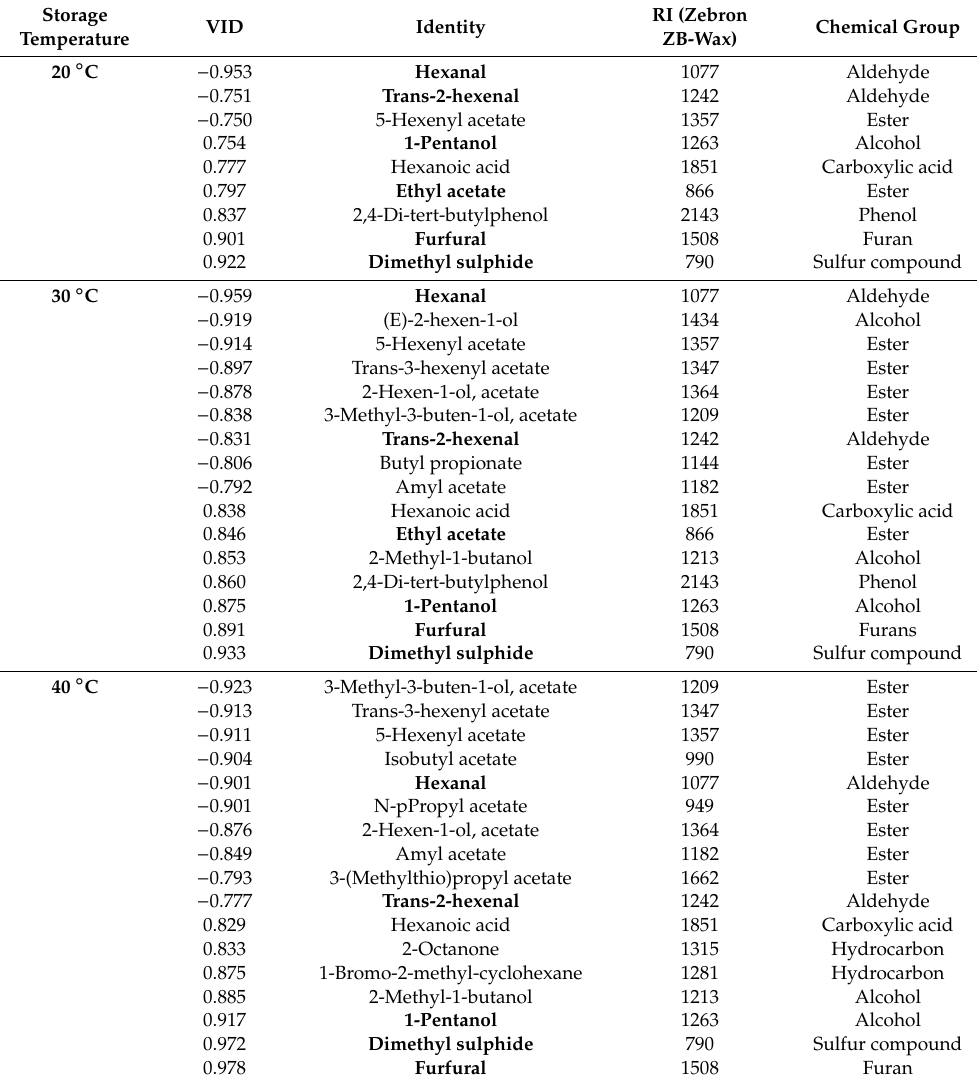
Table 1. Headspace compounds significantly changing during storage at each 20 ◦ C, 30 ◦ C and 40 ◦ C storage temperatures. Volatiles selected as potential shelf life markers / indices are put in bold. The retention index (RI) and chemical family are also listed. The identity of these compounds was further confirmed by injecting pure standard on the same GC-MS